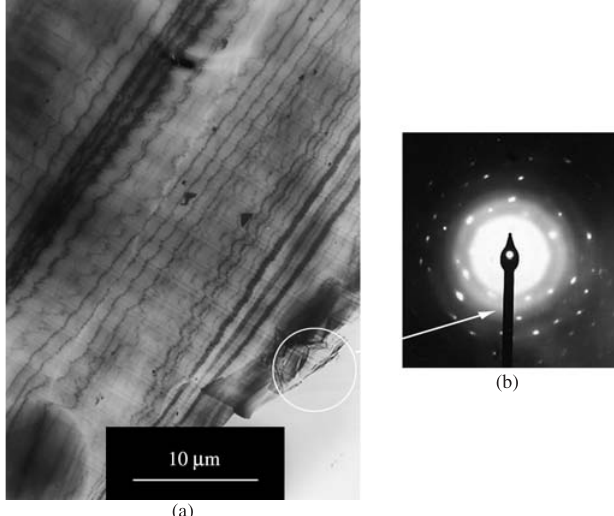
Figure 7. a) Plan-view TEM micrograph of a diamond turned region on the (001) Si surface and; b) electron diffraction pattern from the selected area (corresponding to the thinner edge of the electron-transparent central